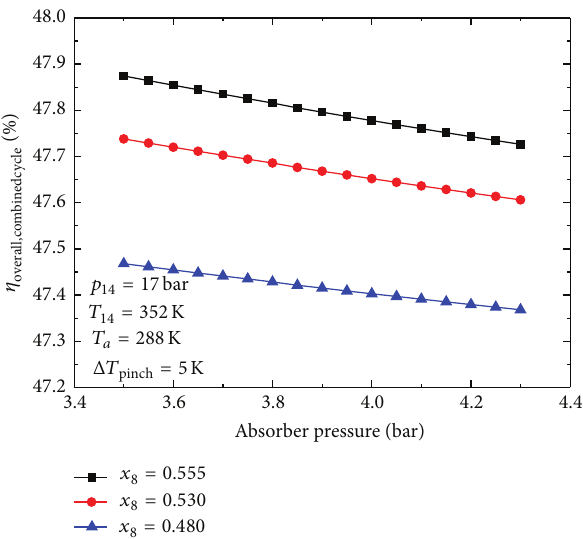
Figure 2: Variation of power output of combined cycle with absorber pressure.